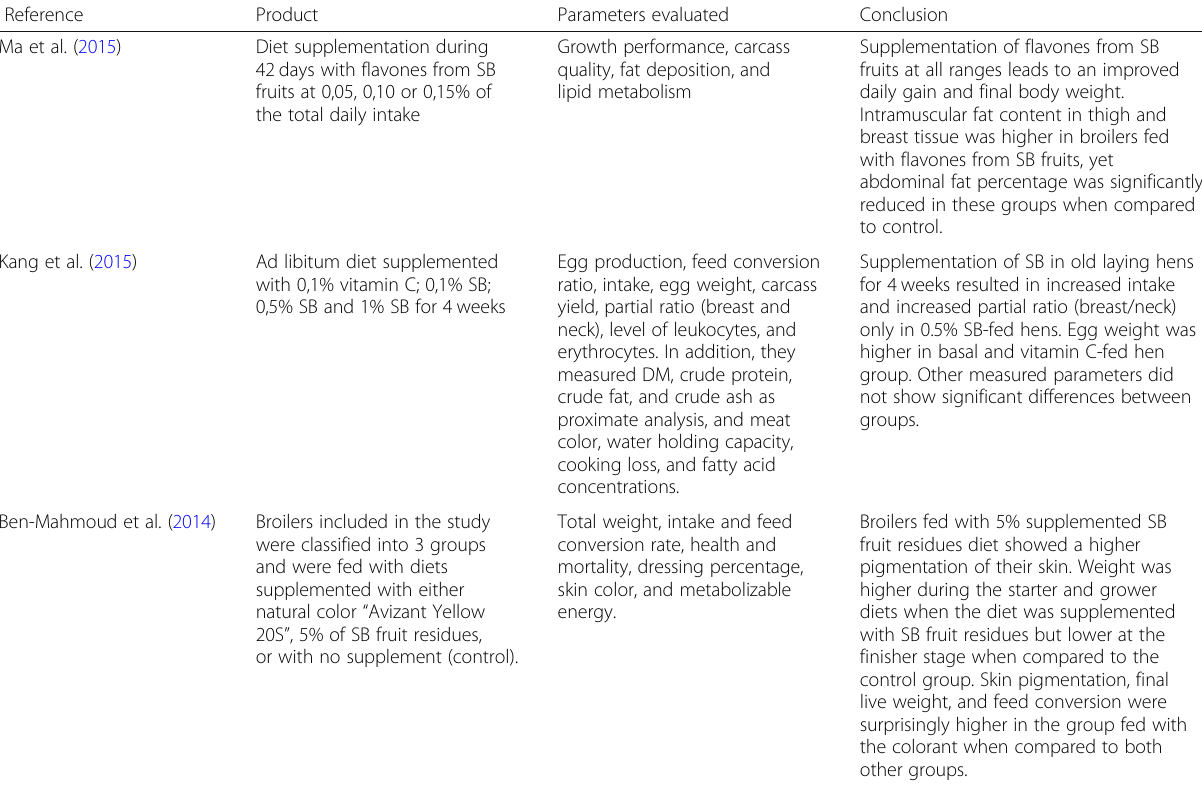
Table 2 Additional articles investigating the effect of SB on broiler overall quality